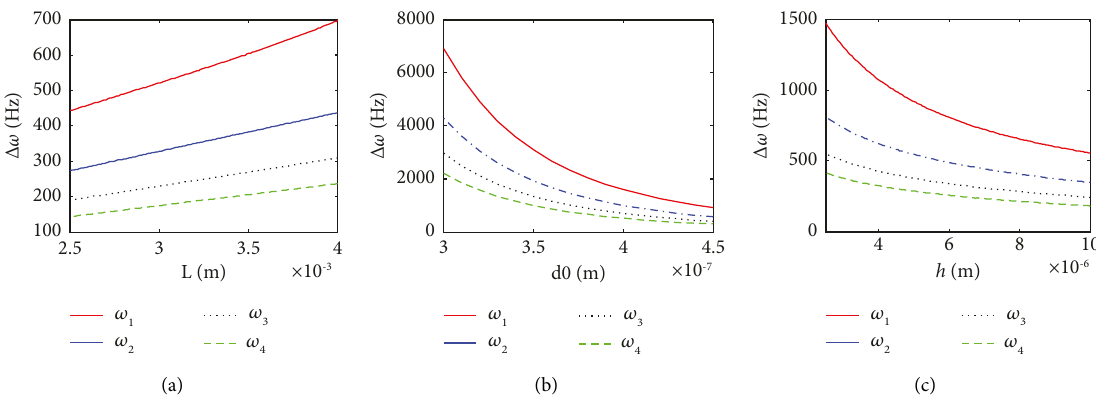
Figure 10: Changes of the resonant frequency differences with system parameters (even modes). From these figures, the following conclusions can be reached: (a) length changes (b) clearance changes (c) thickness